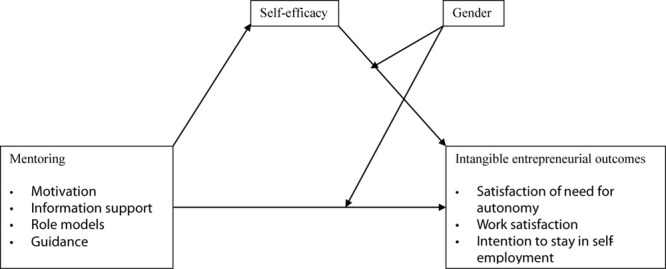
Conceptual model.